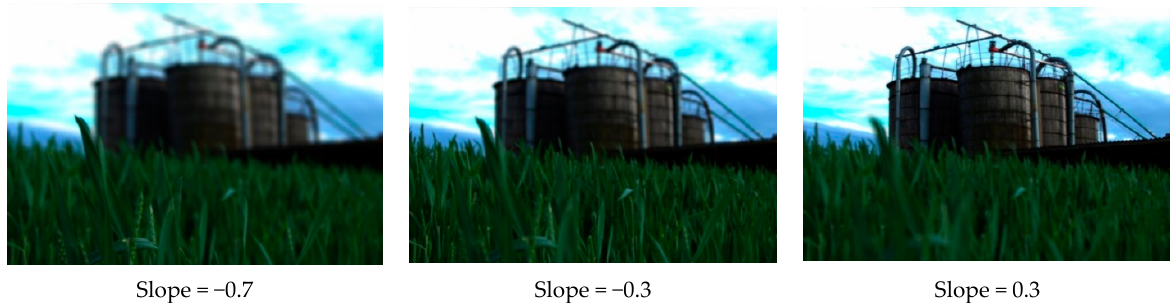
Slope = − 0.7 Slope = − 0.3 Slope = 0.3 Figure 3. Three RIs with different slopes: LF image—Wheat & Silos.